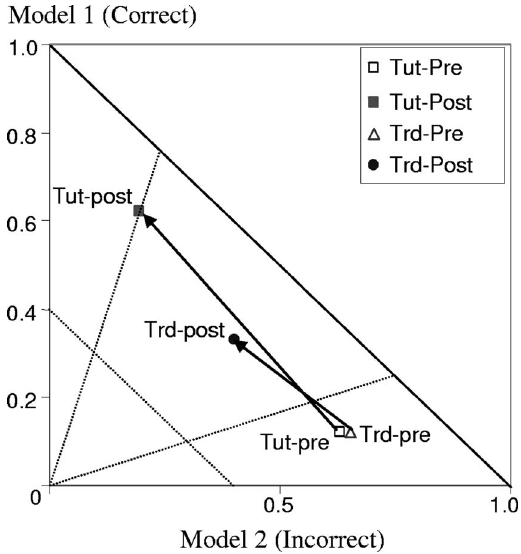
FIG. 5. Model plot of student class model states on force and motion with FCI data from the University of Maryland. For each type of class, we plotted, for pre- and post-results, the first two class model states (cid:1) states with the first and second largest eigenvalues (cid:2) . The two arrows represent the shifts of the first model states the for pre- and post-results of tutorial (cid:1) Tut (cid:2) and traditional (cid:1) Trd (cid:2) mix (cid:1) half and half (cid:2) , a particular student is likely to use the